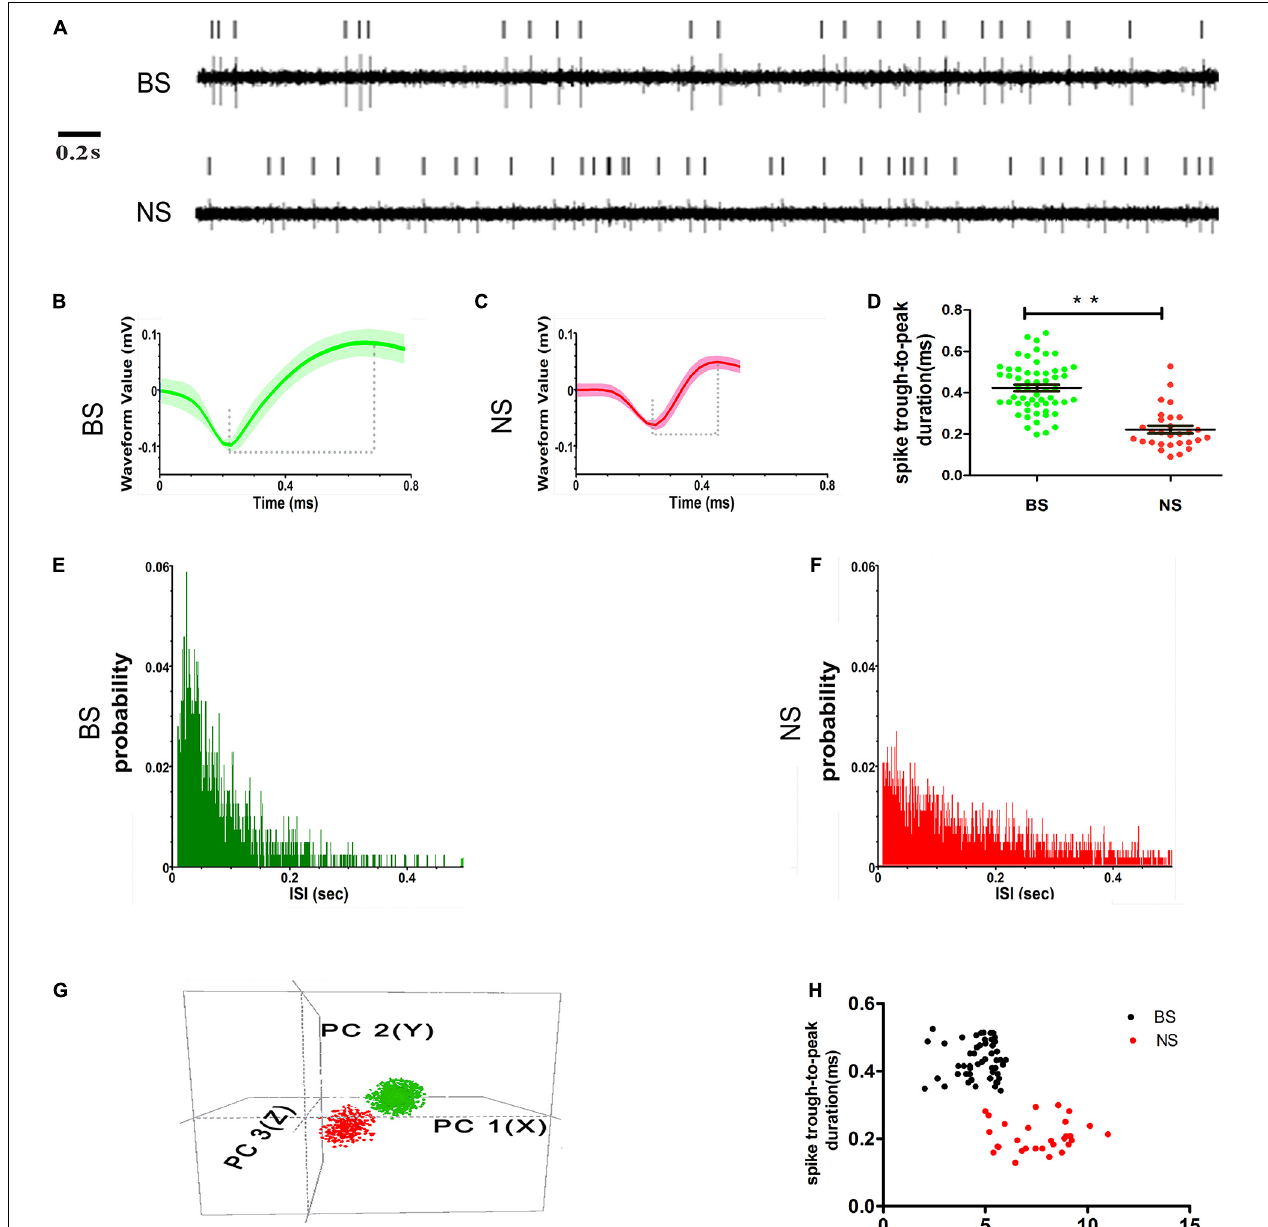
FIGURE 4 | Examples of single units’ sorting technique and electrophysiological identification of BS (putative pyramidal neurons) and NS (putative interneurons) neurons in layer 5 of M1. Vertical lines represent single action potentials in spike training (A) . Electrophysiological identification in the high amplitude and long spike duration (trough-to-peak, between two dashed lines) waveforms of BS (B) and low amplitudes and short spike duration waveforms of NS (C) . The measurement in the two types of spike waveform durations (trough-to-peak) was different (** indicates p < 0.01) (D) . The ISI histograms show a clear refractory period, for the BS firing is characterized as a positively skewed distribution (E) . NS is characterized as relatively broad with a random distribution (F) . Isolated subpopulation neurons as distinct clusters in 3D space based on principal component (PC) analysis correspond to the BS with NS (G) . The scatter diagram plotting the duration versus baseline firing rate for all of the neurons recorded from control animals detected the BS with NS distinctly (H)